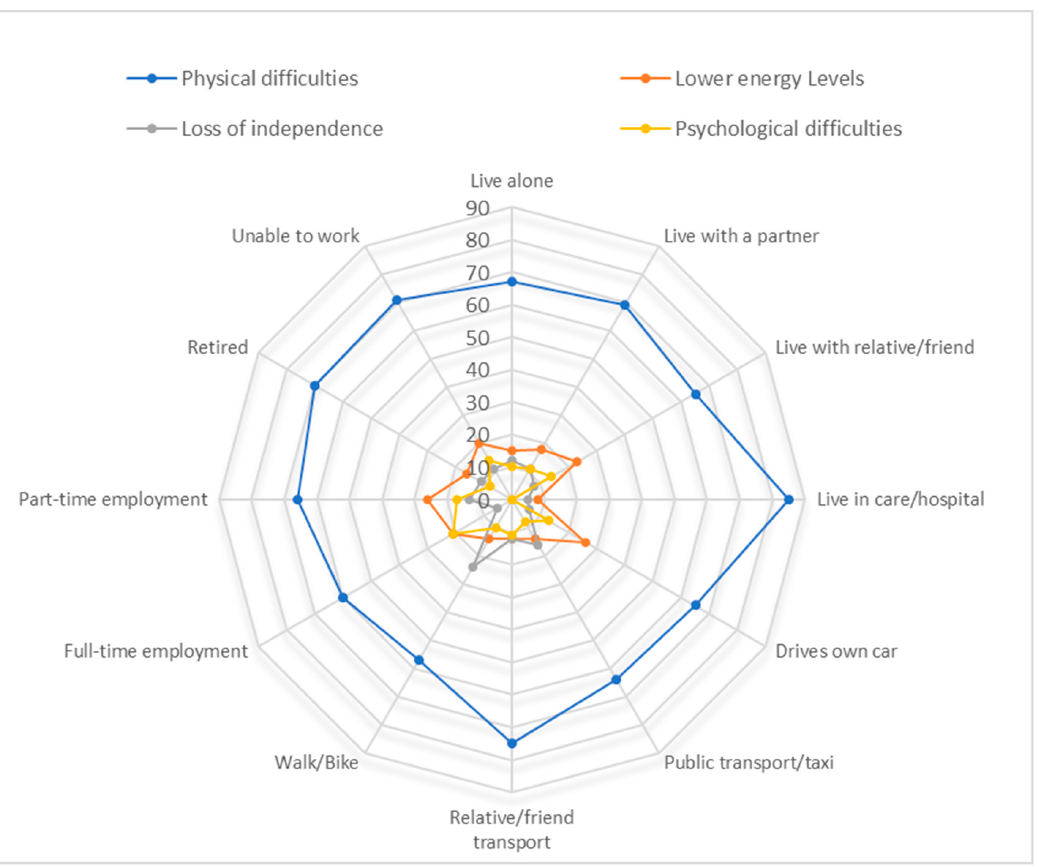
Figure 2. The three most reported barriers to activity (%) at 6 month follow-up by participant’s living situation, transport use and employment status.